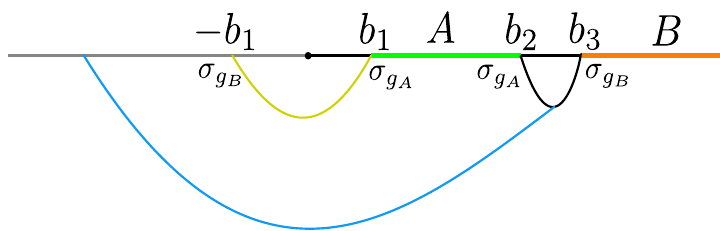
Figure 3. OPE channel corresponding to the present